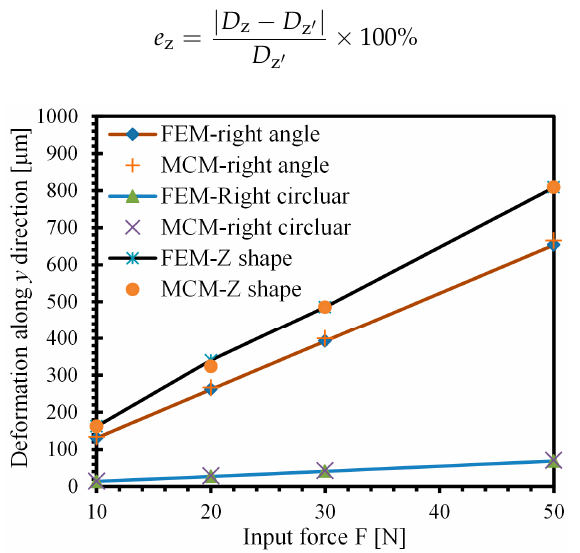
Figure 2. Comparison of FEM and MCM results for three kinds of flexure hinges.